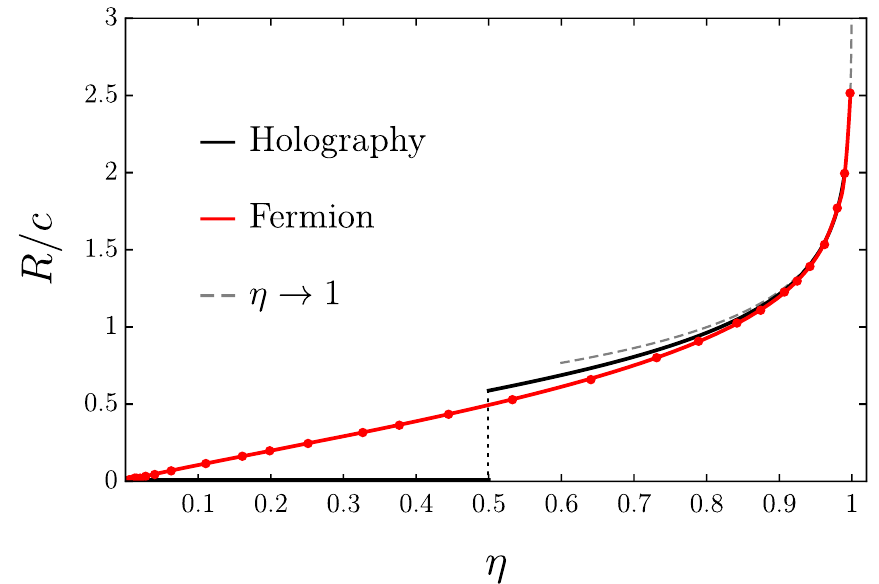
Figure 1 . Re(cid:13)ected entropy normalized by the central charge, R=c , as a function of the conformal cross-ratio (cid:17) for holographic Einstein gravity (black) and a free fermion (red line and dots). The gray dashed line corresponds to the general-theory behavior for (cid:17) ! 1. For (cid:17) = 1 = 2 the holographic result undergoes a phase-transition and the leading N term drops to zero for smaller values of the cross